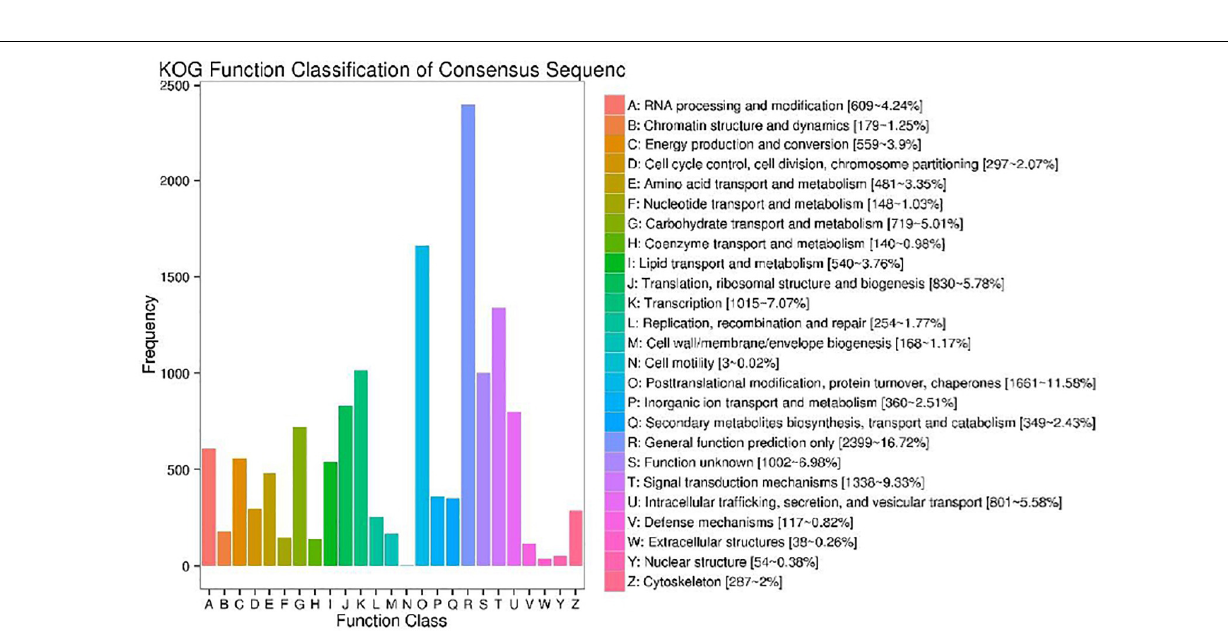
Frontiers in Plant Science |